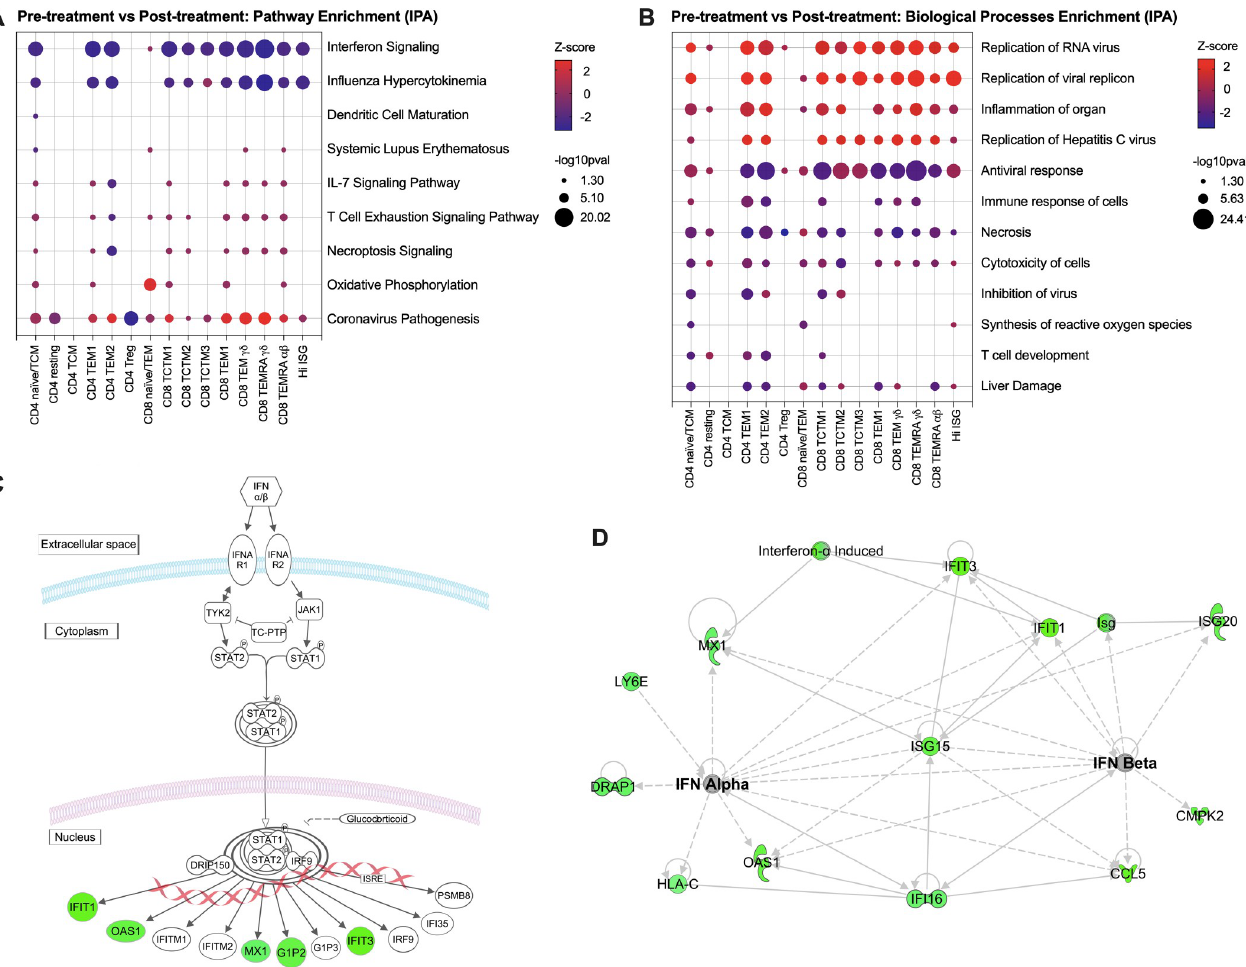
Fig 3. Enrichment analysis of differentially expressed genes between post and pre-treatment for each T cell cluster. ( A ) Plot of the top significant enriched IPA pathways among T cell clusters, for significantly up- and downregulated genes, showing z-score and -log10pvalues. ( B ) Plot showing the comparison of top significantly enriched biological functions (IPA) among T cell clusters, z-score and -log10pvalues indicated direction and significance, respectively. ( C ) Cartoon representation of the IFN signaling in the Hi-ISG T cell cluster. Genes in green are significantly downregulated comparing post-treatment to pre- treatment samples. ( D ) Gene-concept network between interferon alpha/beta signaling for the set of significantly differentially expressed genes for the Hi-ISG T cell cluster. Genes in green are significantly downregulated comparing post-treatment to pre-treatment. TCM: T central memory; TEM: T effector memory; Treg: T regulatory; TCTM: T central-transitional memory; TEMRA: Terminally Differentiated Effector Memory.